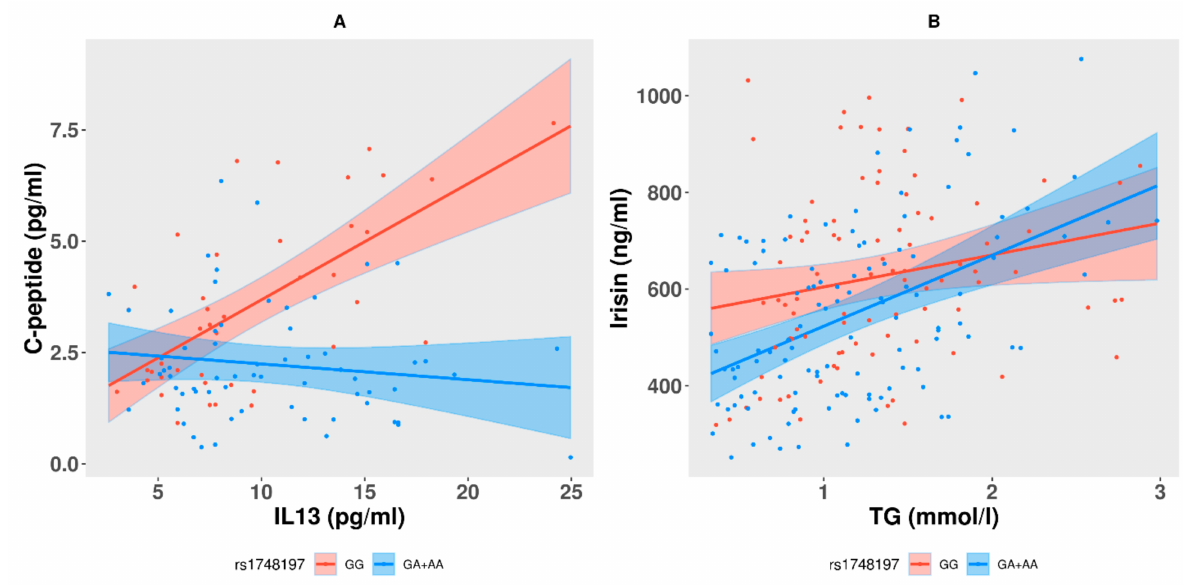
Figure 2. Interactions observed in ( A ) c-peptide with IL13 (negative correlation) and in ( B ) irisin with TG (positive correlation) in interaction with the (GA + AA) carrier genotype at the study variant of